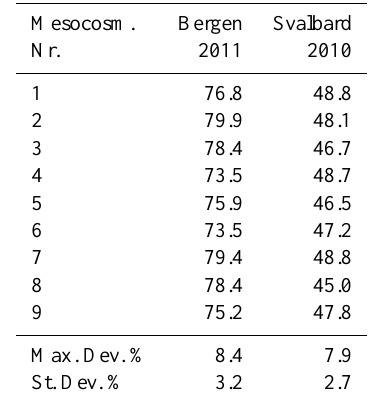
Table 2. Measured volume of nine mesocosms in two experiments: Bergen 2011 and Svalbard 2010 including maximum and standard deviations from mean measured volumes. In Bergen 2011, bags reached overall 25m below the surface, geometrically calculated volume for the bags, funnel shaped in the bottom 2m, is 74.3t. In Svalbard 2010, cylindrical 15-m-deep bags are geometrically calcu- lated to hold